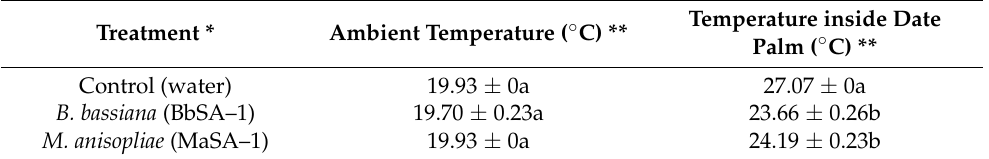
Table 2. Temperatures in treated and control trees.